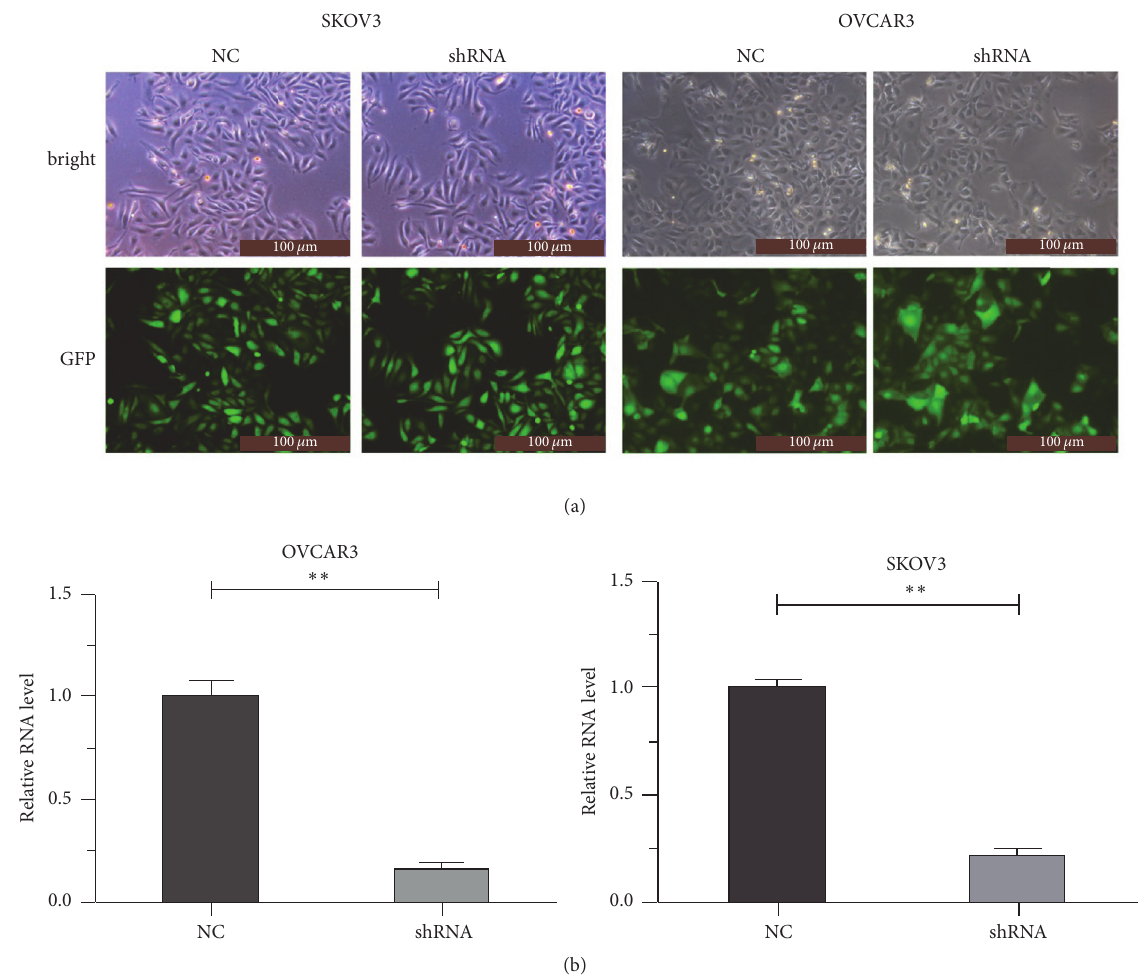
Figure 2: Successful depletion of MIR4697HG by a specific shRNA. (a) After transfection of negative control (NC) or specific shRNA into cells, cells were photographed under a bright vision and a fluorescence microscopy. Ninety percent cells were shown to express green fluorescence protein (GFP). (b) The specific shRNA decreased the MIR4697HG level by up to 72% in SKOV3 cells and 84% in OVCAR3 cells. ∗∗ 𝑝 < 0.01